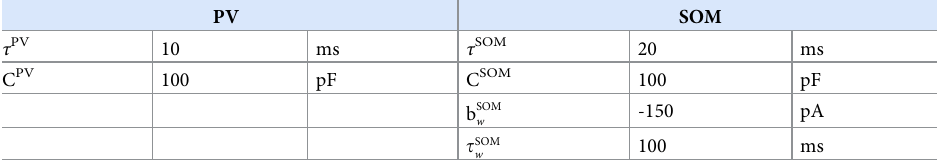
Table 2. Parameters of the PV and SOM interneuron models. PV